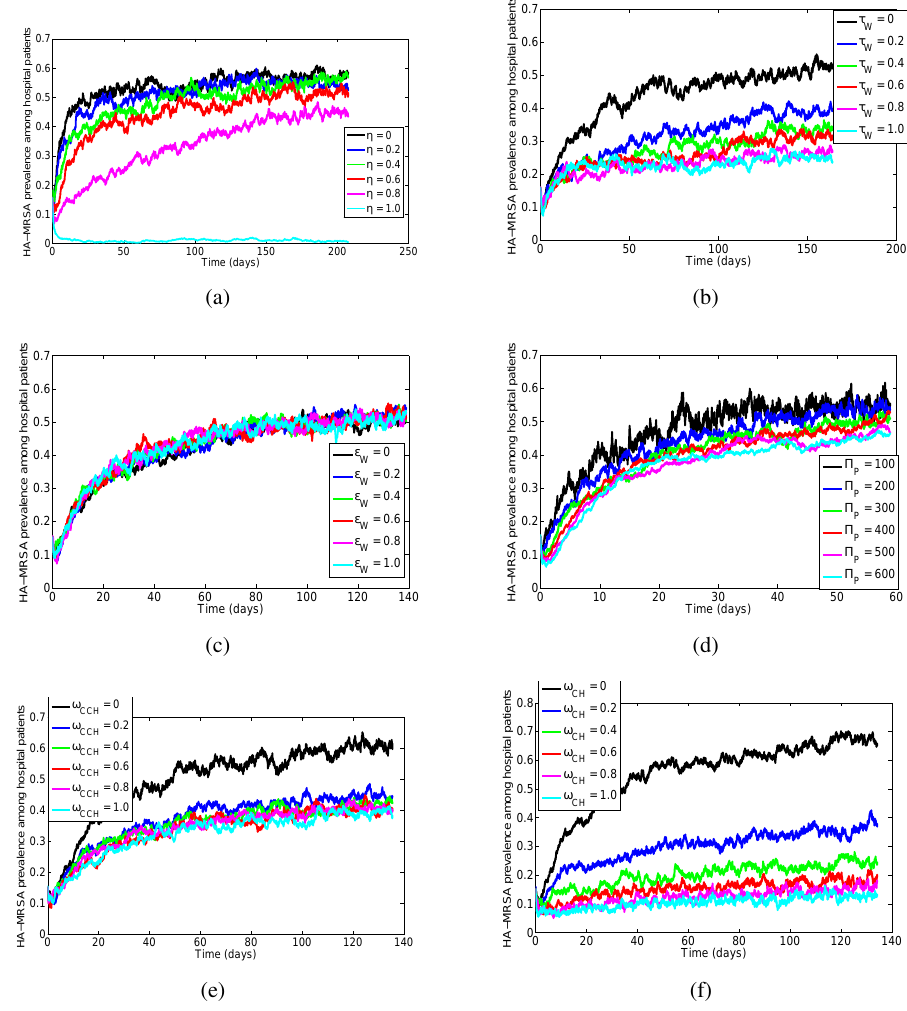
Fig. 8. Simulation of stochastic model (2.1) using the prevalence of CA-MRSA among hospital patients as model output. Varying: (a). hand washing compliance rate ( η ); (b). health-care workers decontamination rate ( τ W ); (c). environmental contamination rate ( (cid:15) W ); (d). hospital admission per day ( Π P ); (e). isolation rate of colonized patients with CA-MRSA ( ω CCH ); (f). isolation rate of colonized patients with HA-MRSA ( ω CH ).